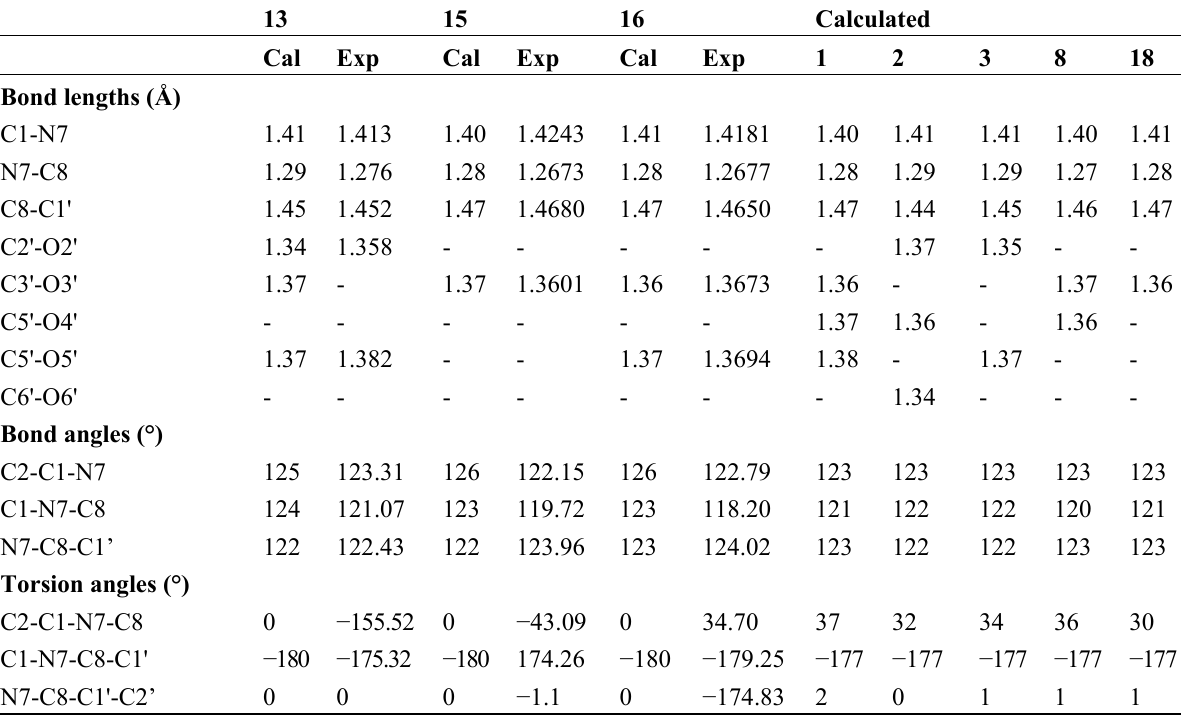
Table 7. The calculated and experimental values of the bond lengths, bond angles and torsion angles of compounds 13 , 15 , and 16